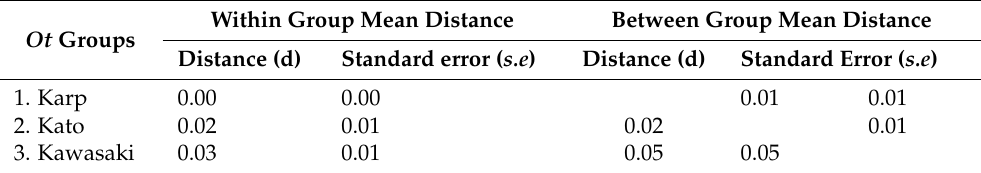
Table 2. Analysis of mean distance within and between O. tsutsugamushi